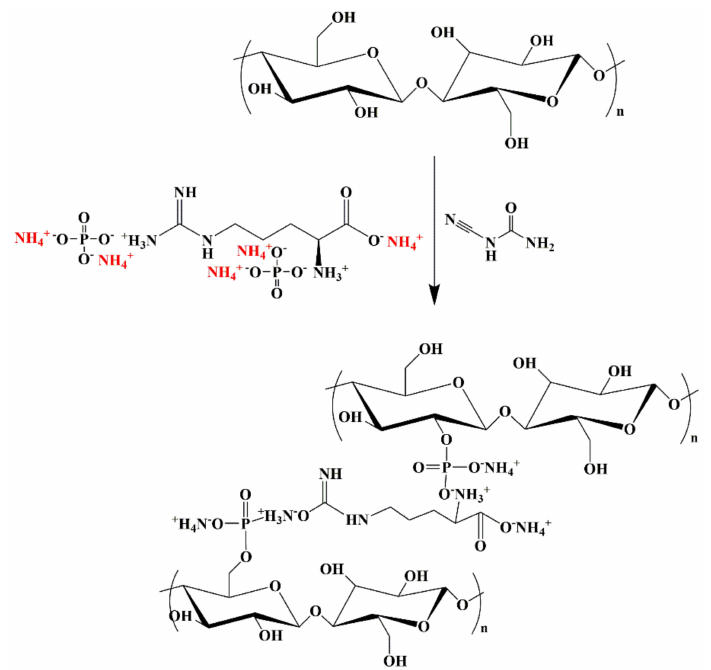
Figure 2. Synthetic route of flame − retardant lyocell